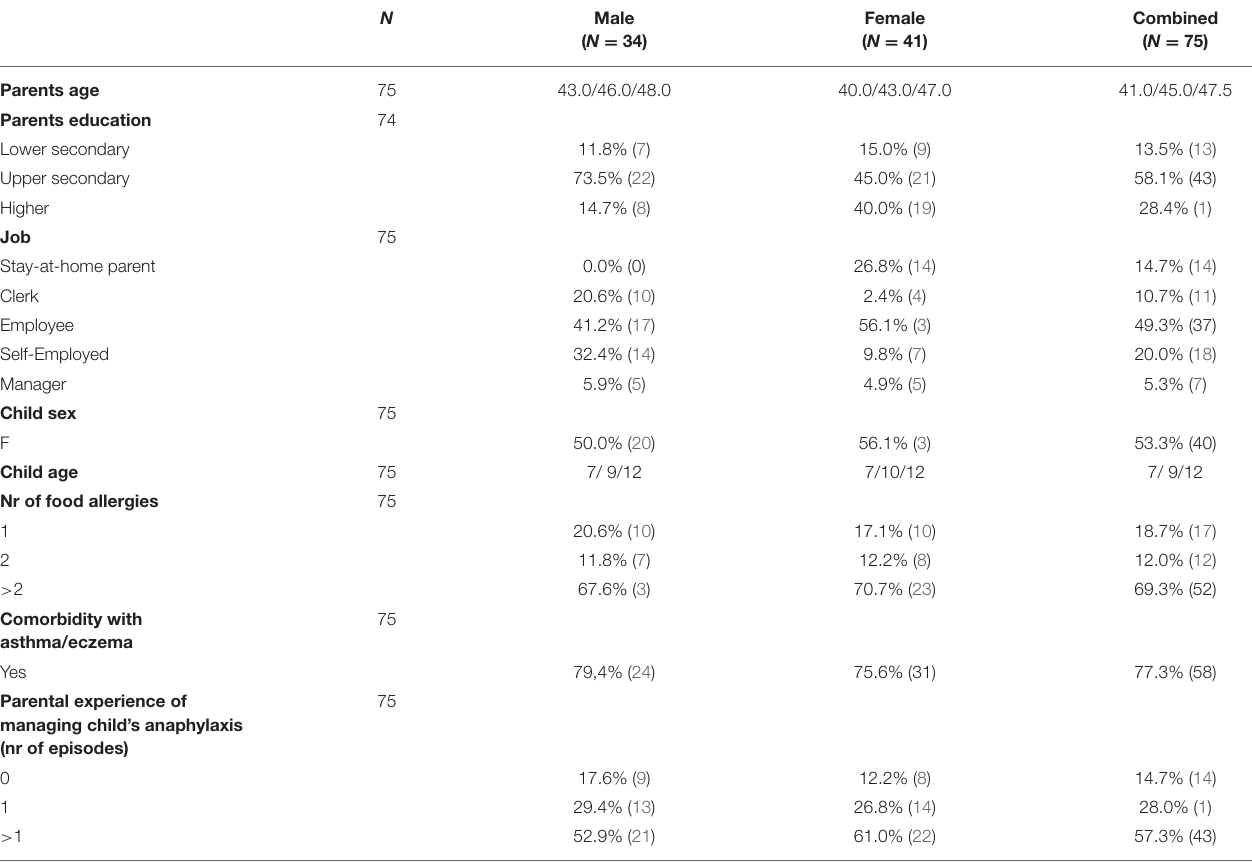
TABLE 1 | Participants’ characteristics stratified by parent’s gender and overall, with percentages (number of cases) or median (first, third quartile), as appropriate.